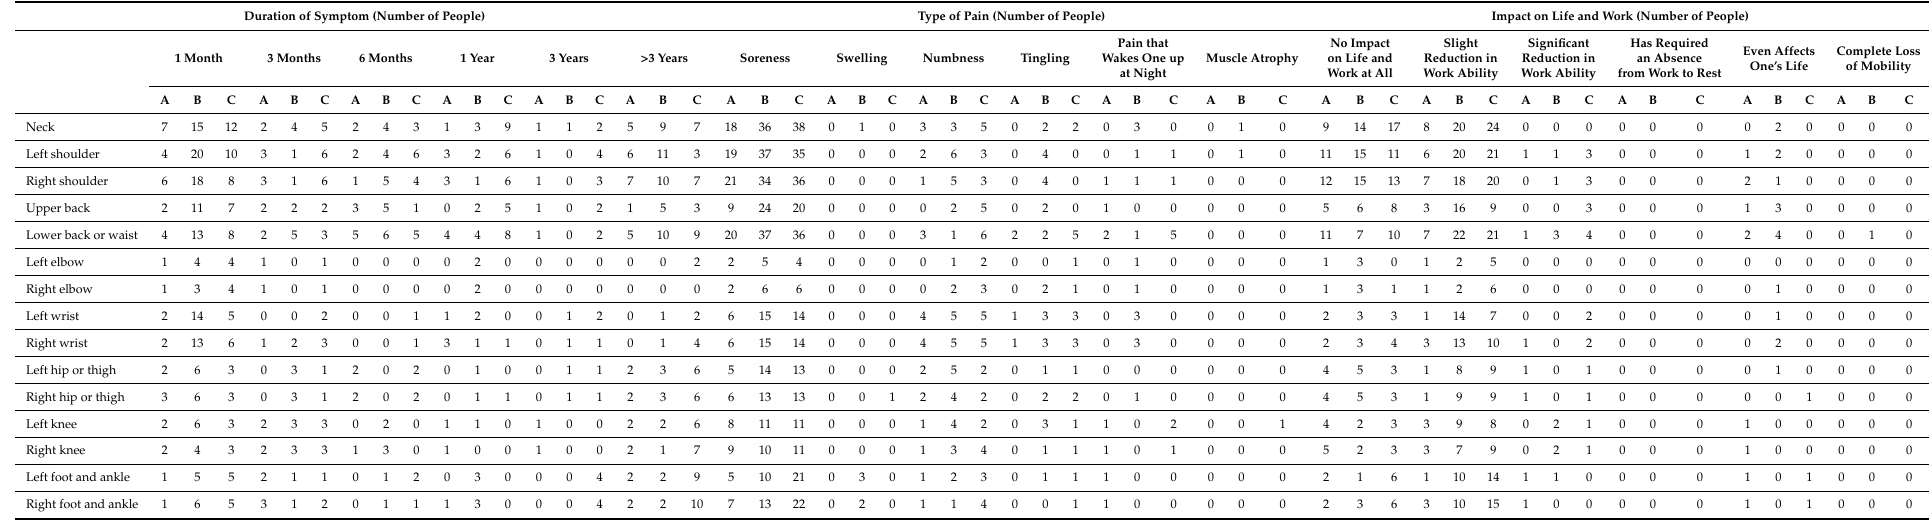
Table A1. Duration of symptom, type of pain, and impact on life and work for each body